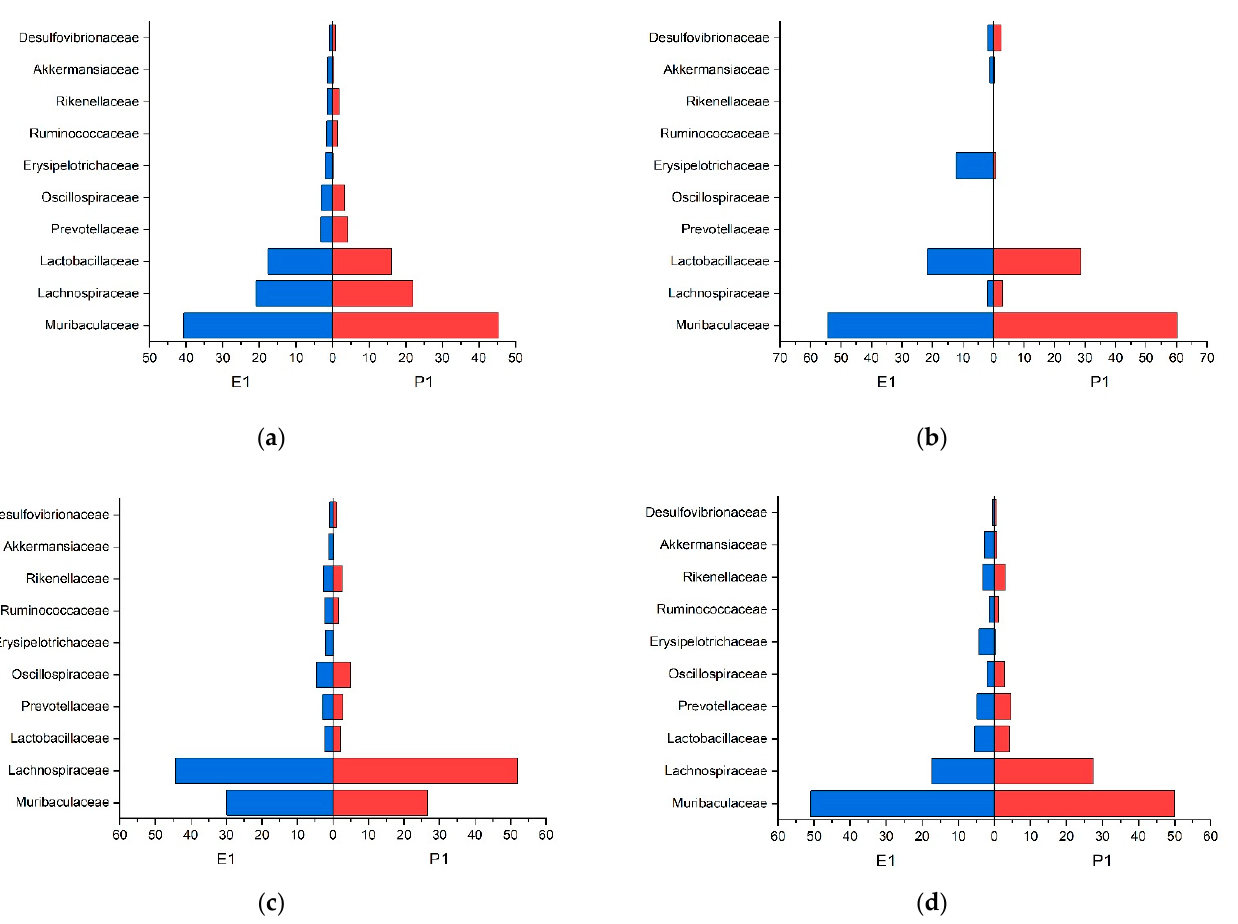
Figure 3. Population pyramid of abundant families of trial 1 given in relative abundance (percent) ( a ) stomach; ( b ) small intestine; ( c ) cecum; ( d ) colon.